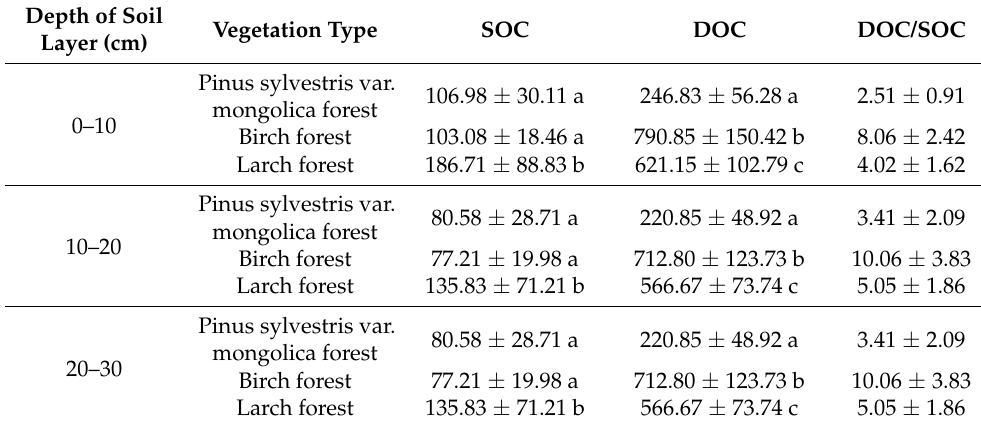
Table 1. Content of SOC and DOC in pinus sylvestris var. mongolica, birch, and larch forests. Depth of